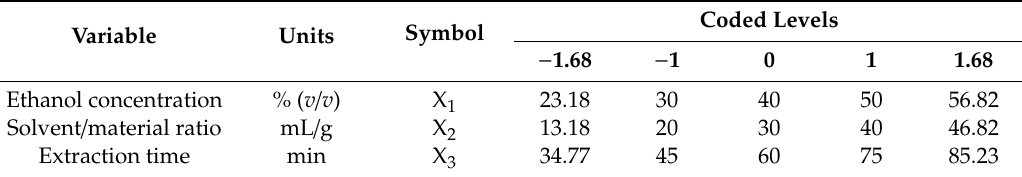
Table 1. Five levels of the three variables of the extraction process.